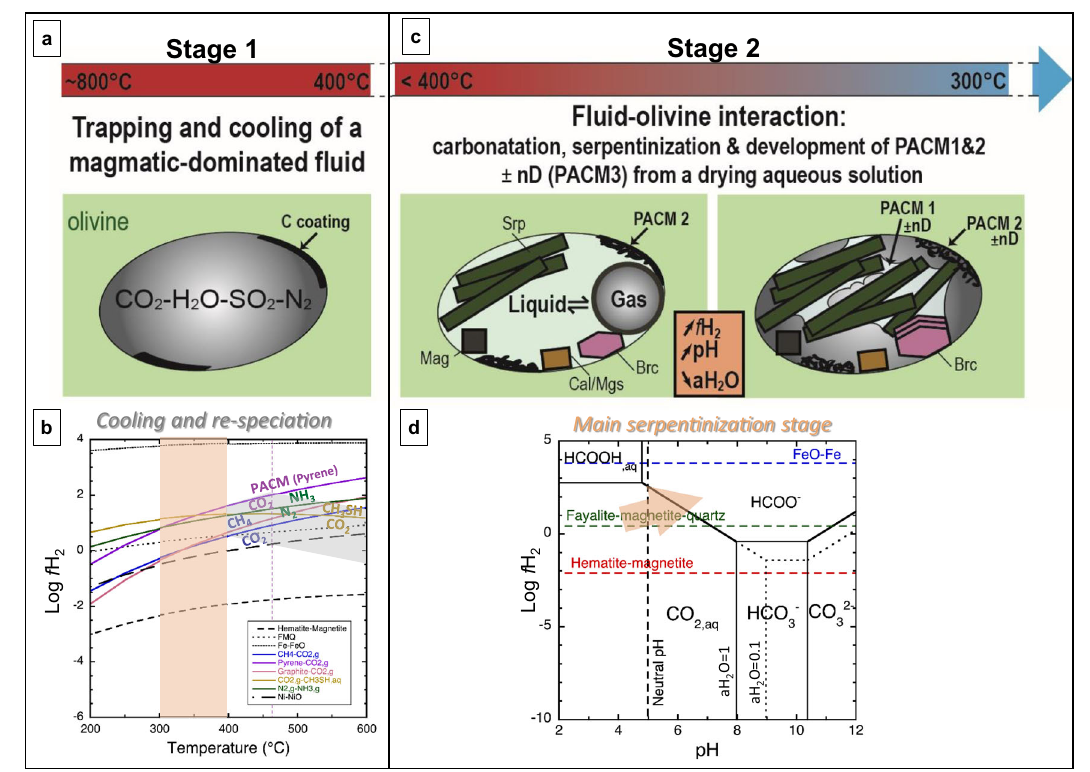
Fig. 5 | Proposed scenariotoaccount for thechemicalandstructuraldiversity of the different types of carbonaceous material in microreactor-like fl uid inclusionshostedinserpentinizingolivinefromthedeepoceaniclithosphere. a During Stage 1 , the trapped fl uid cools down to 400°C at 2kbar and its spe- ciation evolves as depicted by the gray area in diagram b , for a plausible range of initial redox conditions (Supplementary Fig. 3). The path followed by the most reduced fl uids (Log f H 2 ≥ FMQ) cross-cut the pyrene-CO 2 curve between 400°C and 450°C, allowing the early formation of pyrene, analogous to the most aro- matic PACM observed on olivine walls (PACM2). In these fl uids, CO 2 can also partially convert to CH 3 SH and CH 4 , and N 2 to NH 3 , before reaching 400°C; i.e., before serpentinization initiates. The vertical orange area depicts the main ser- pentinization fi eld (stage 2). c During stage 2 , for T<400°C (2kbar), water becomes liquid and olivine highly reactive with an expected major stage of ser- pentinization at T between 300 and 400°C that produces serpentine, brucite,